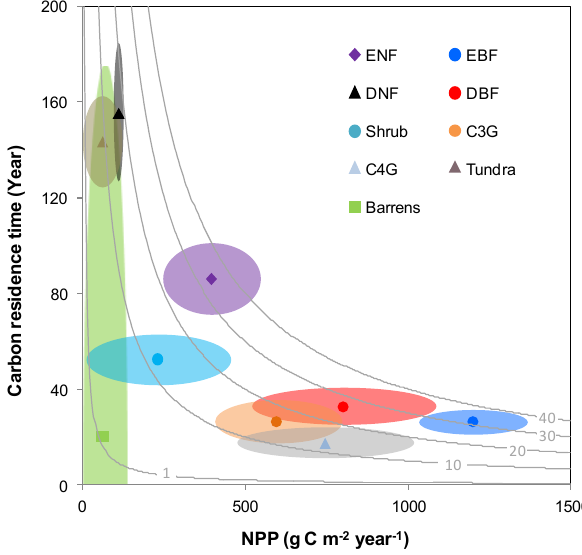
Fig. 3. Determination of carbon (C) influx (i.e., NPP) and resi- dence time ( τ E ) on ecosystem carbon storage capacity in various biomes simulated by the Community Atmosphere–Biosphere–Land Exchange (CABLE) model. 95% of values from all grid cells are plotted in the shaded areas with means at the dots. The hyper- bolic curves represent constant values (shown across the curves) of ecosystem carbon storage capacity. ENF – evergreen needleleaf forest, EBF – evergreen broadleaf forest, DNF – deciduous needle- leaf forest, DBF – deciduous broadleaf forest, Shrub – shrubland, C3G – C3 grassland, C4G – C4 grassland, and Barrens – semiarid barrens (adopted from Xia et al.,